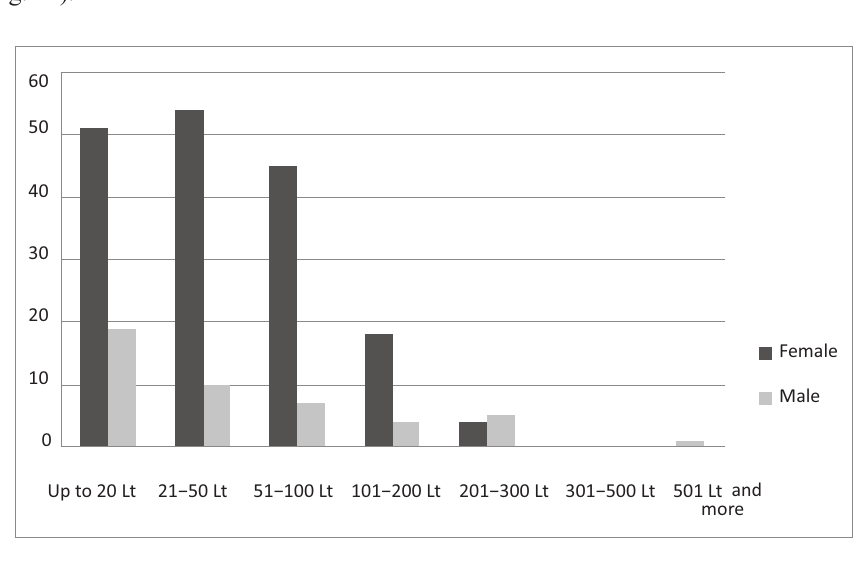
Fig. 21. Correlation between expenses during the festival period and gender